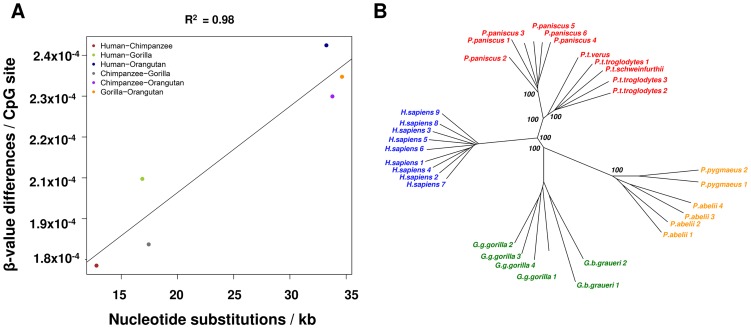
Methylation patterns mimic sequence based phylogenetic relationships.(A) Methylation changes correlate with DNA sequence changes. x-axis shows the number of nucleotide substitutions between two species per kb, y-axis shows the changes in methylation based on β-values. (B) Neighbor-joining tree based on methylation data from probes with a perfect match in all reference genomes (31,853 autosomal CpGs). Bootstrap values (1,000 permutations) are shown for each node.